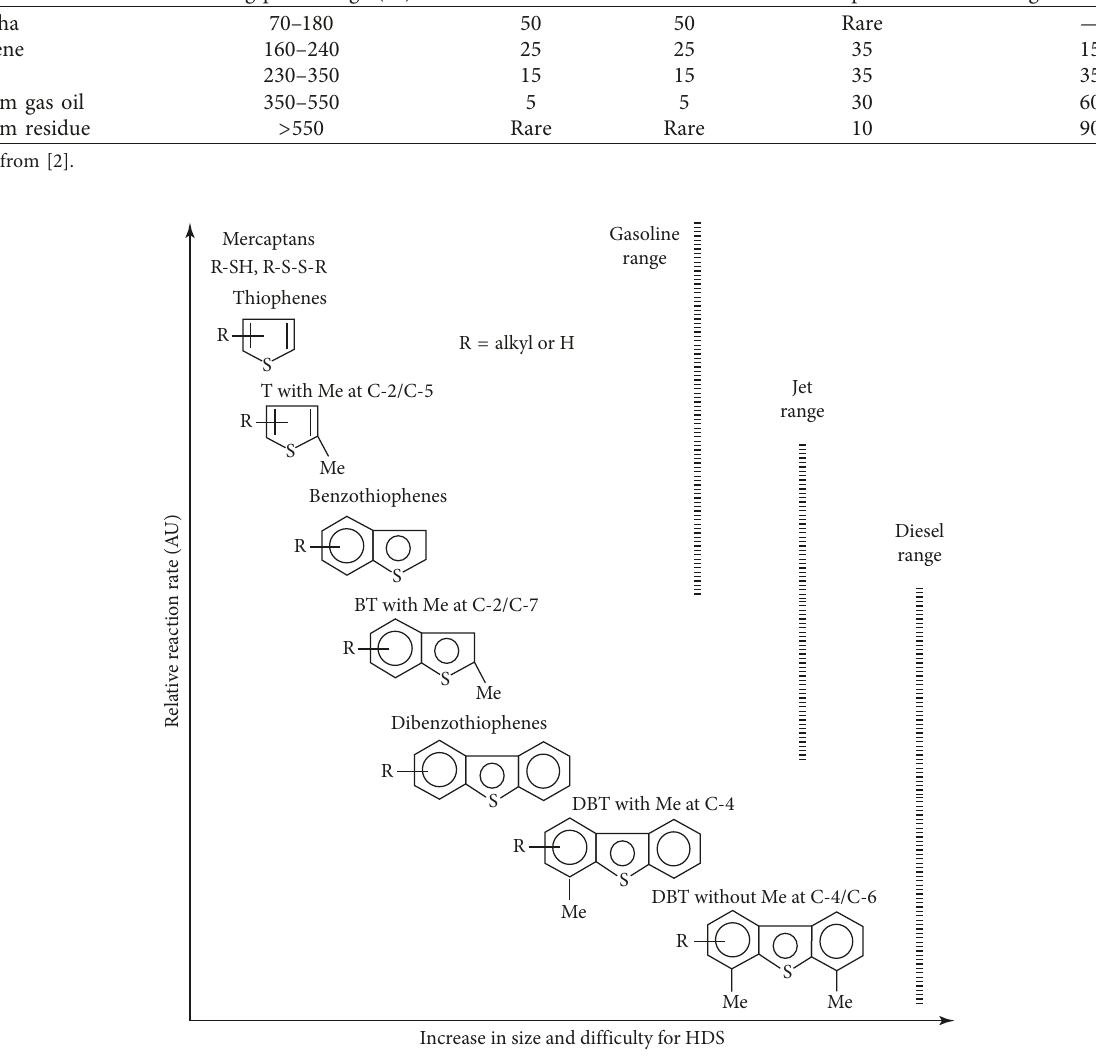
Figure 2: HDS reactivity of various organic sulfur compounds with respect to their ring sizes and alkyl substitutions. T: thiophene, BT: benzothiophene, DBT: dibenzothiophene, and Me: methyl-group (taken from